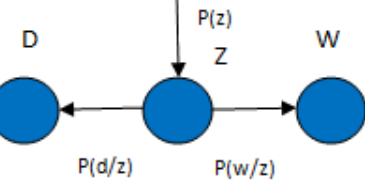
Fig. 3: Graphical representation of the aspect model in a symmetric form. D represents samples, W tokens and Z